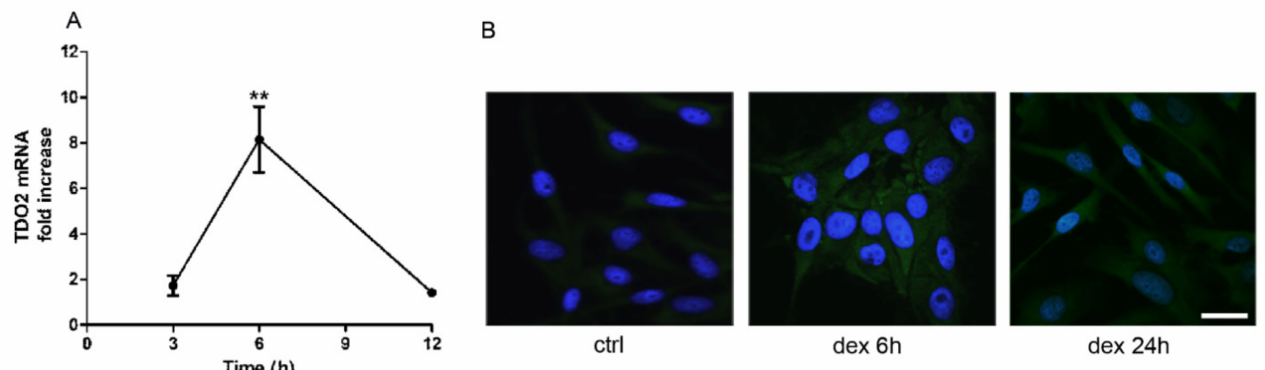
Figure 2. Dexamethasone (dex) increases mRNA and protein expression of TDO. ( A ) Cells were treated with dex (25 µ M) for different time points. RT-PCR shows time-dependent increase in mRNA of TDO2. Data are plotted as mean ± SEM ( n = 8, ** p < 0.01 vs. control). ( B ) Cells treated without (ctrl) or with dex (25 µ M) for 6 or 24 h, then subjected to immunofluorescence, TDO (green fluorescence), nuclei (blue). Representative photomicrographs at 40 × magnification are shown. Scale bar 20 µ